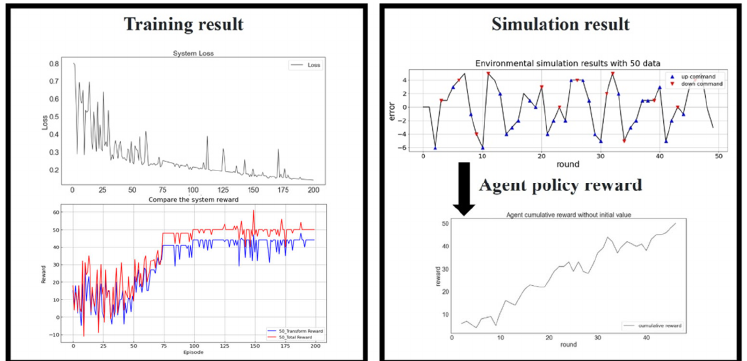
Figure 12. Training results for 50 data. Loss function ( top left ), reward ( bottom left ), simulated platform positioning ( top right ), and the agent policy reward ( bottom right ).